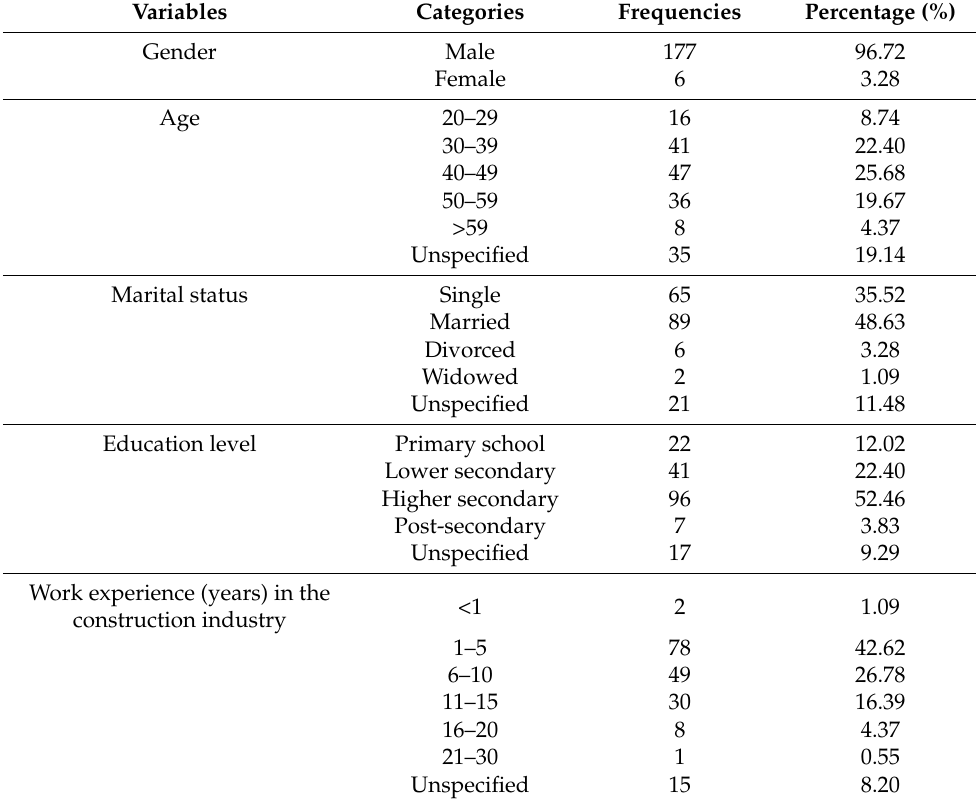
Table 2. Participant demographic information ( n =